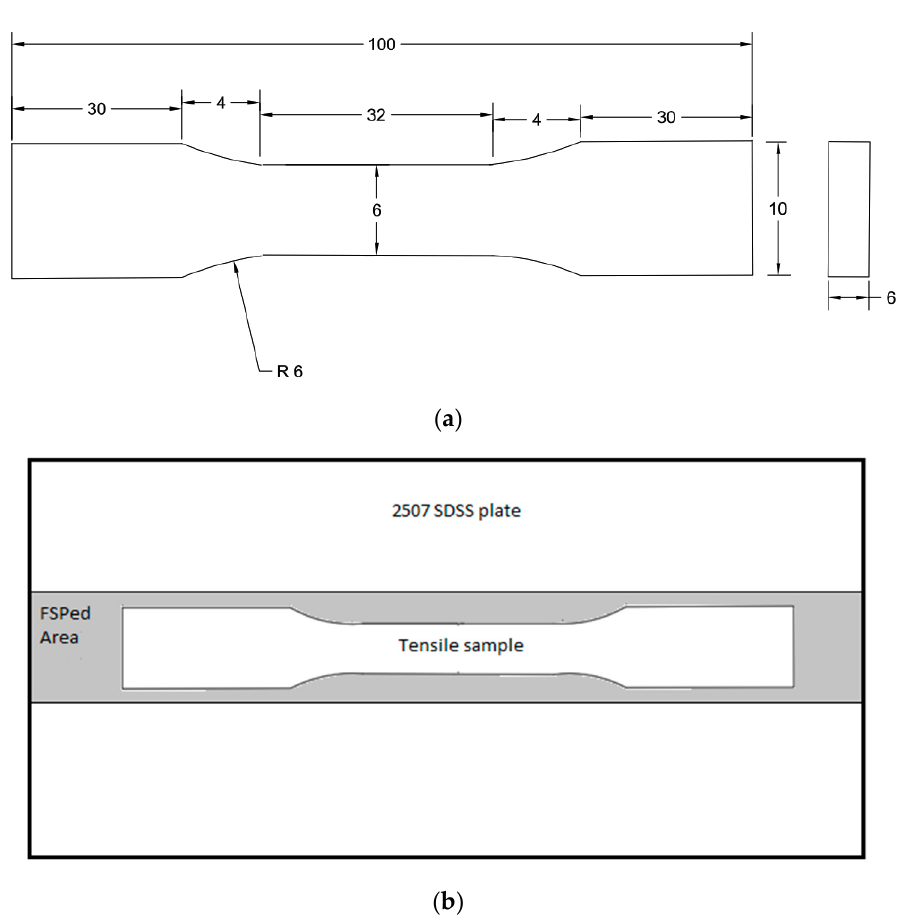
Figure 3. Tensile sample: ( a ) geometry and dimensions in mm, ( b ) sample location in the processed area.